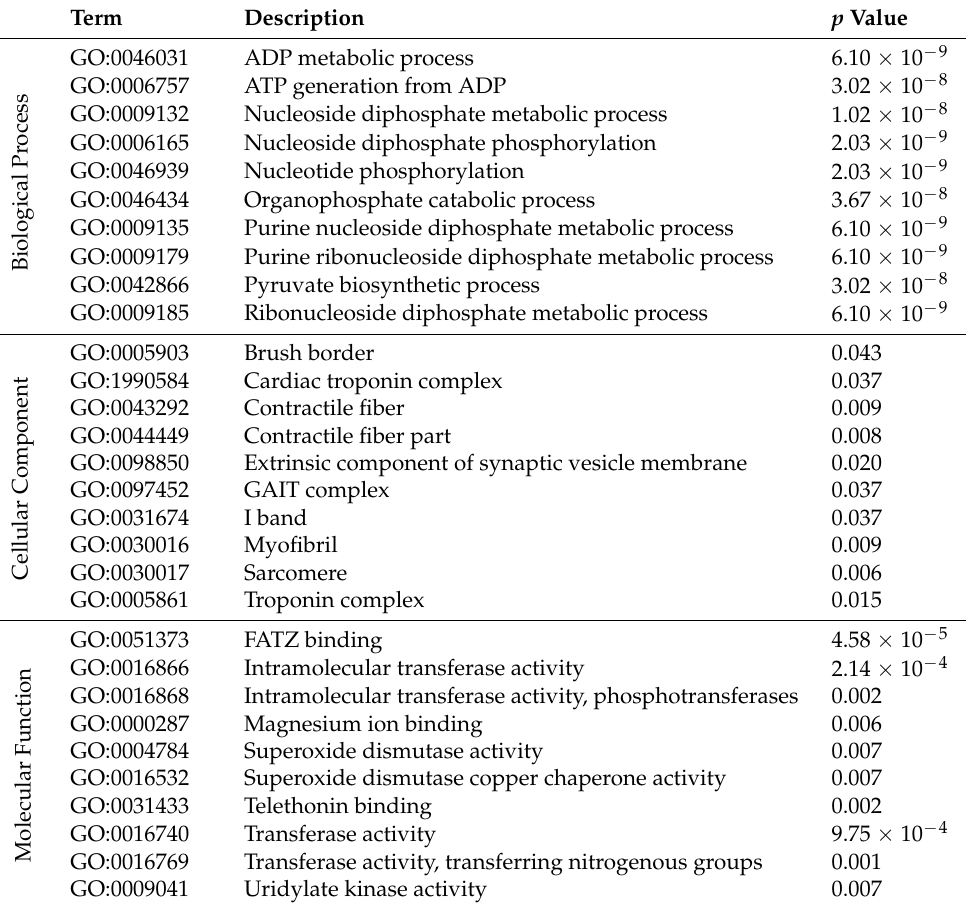
Table 3. Gene ontology classification results of differentially expressed proteins of 6 h vs. 0 h PM. Term